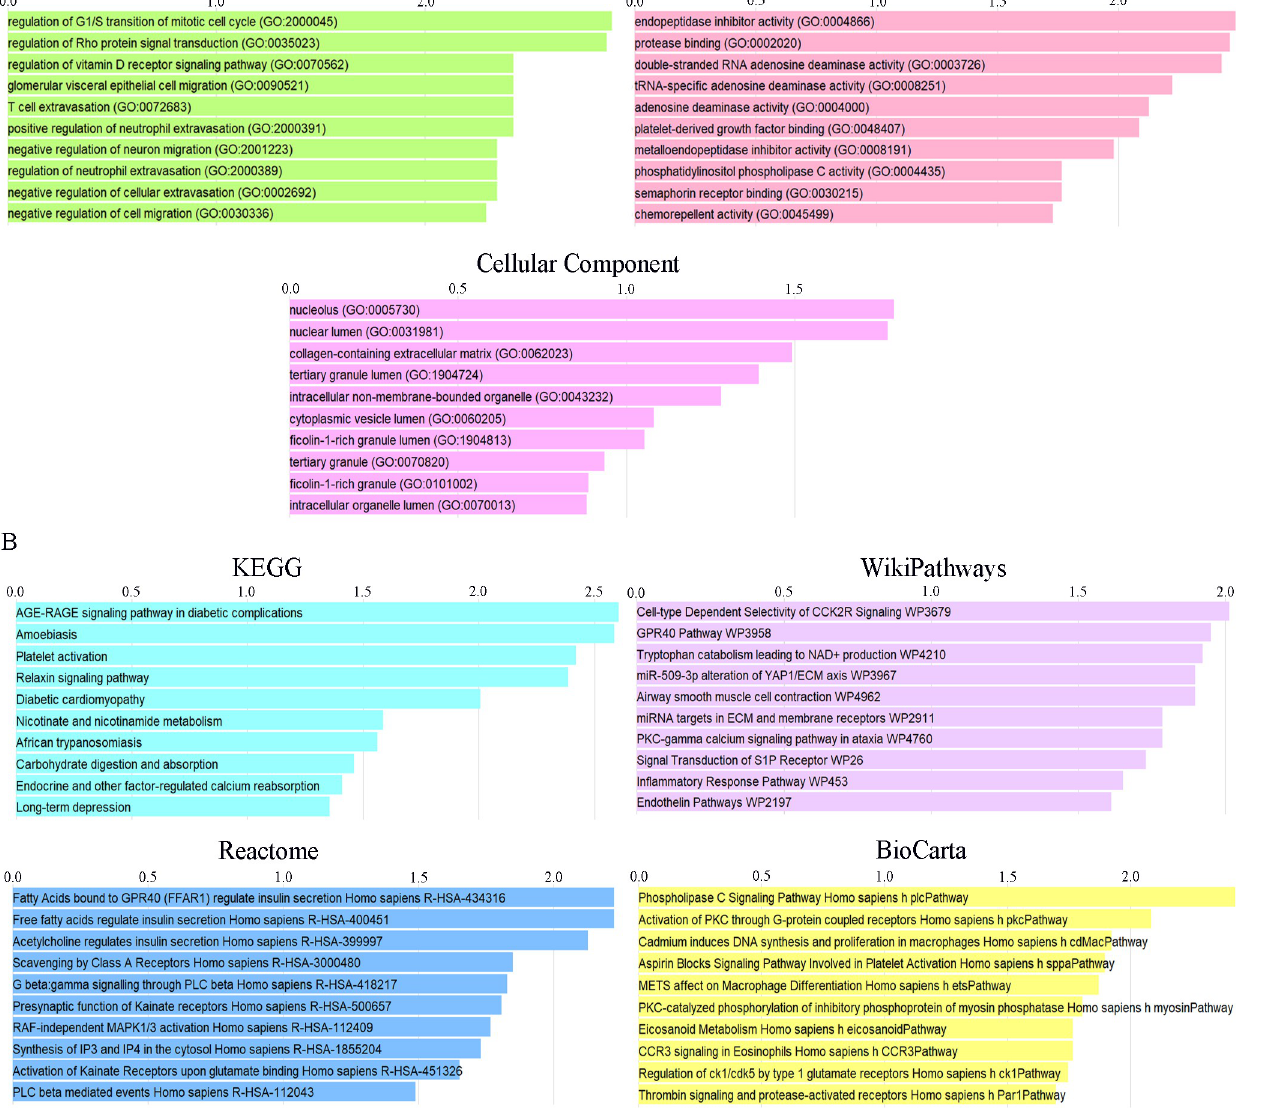
PLOS ONE | https://doi.org/10.1371/journal.pone.0265221 March 10,